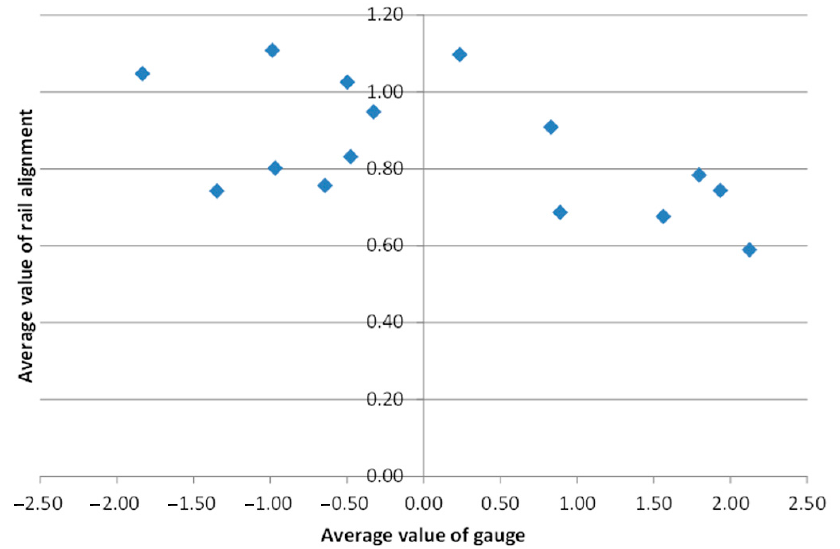
Figure 7. Average gauge and rail alignment values of sub-sections (all dimensions are in mm).